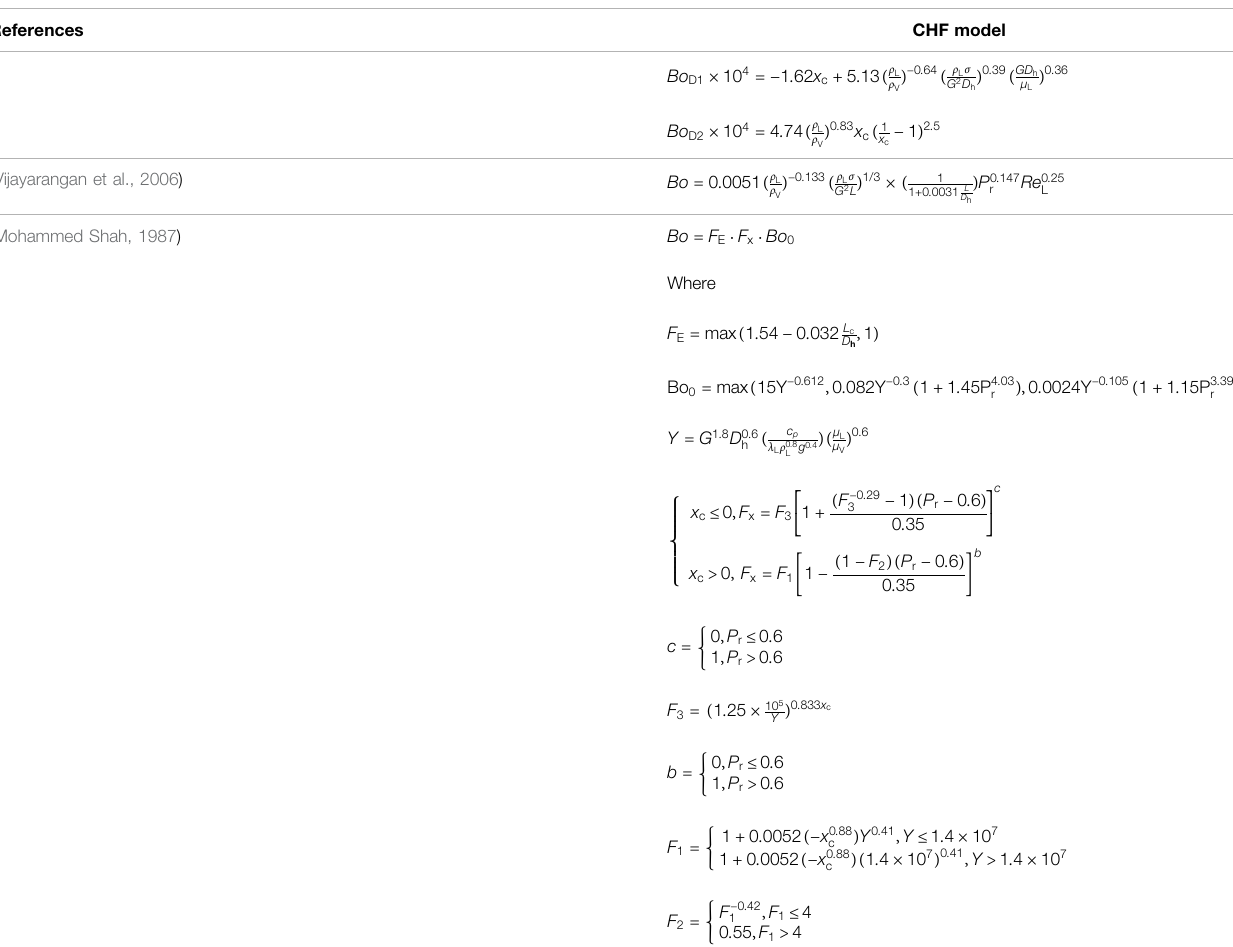
TABLE 2 | ( Continued ) CHF prediction models for high-pressure